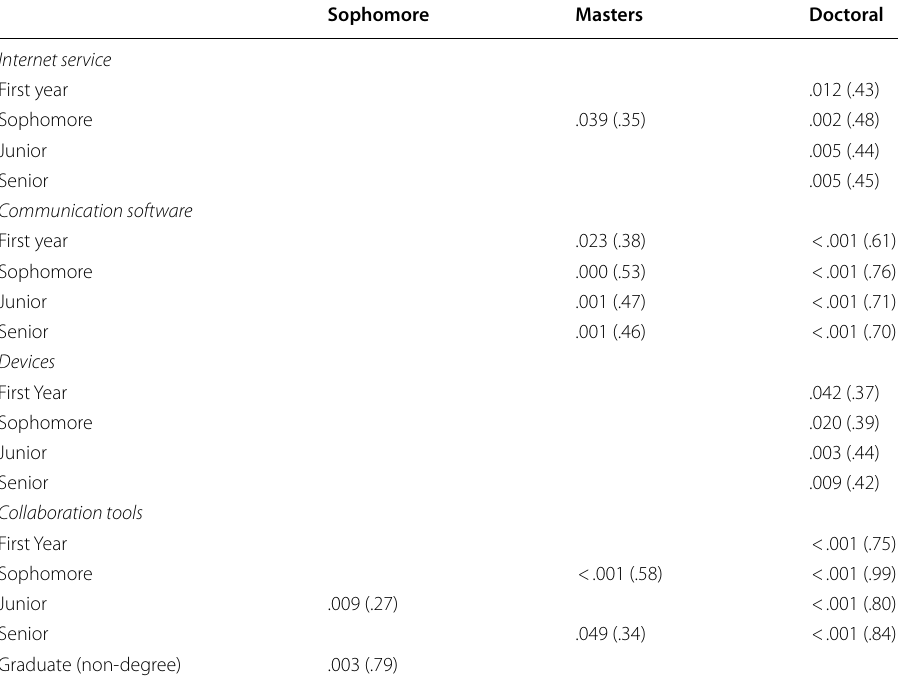
Table 7 Significance (effect sizes) for significant differences across class standing for the four access